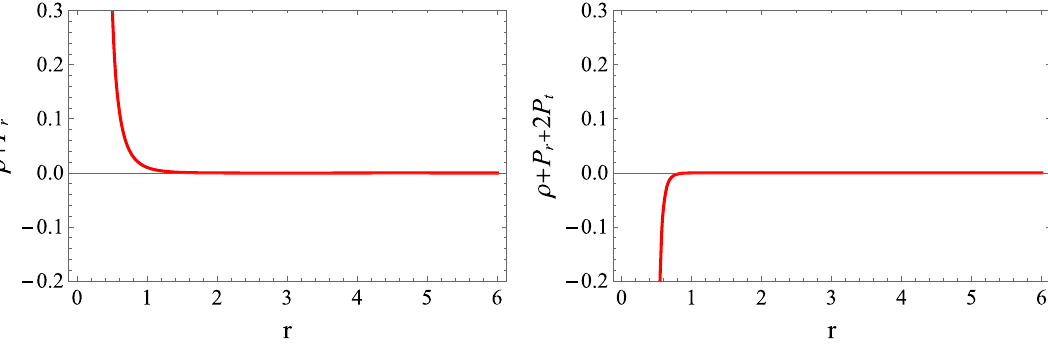
throughout the spacetime. We use the numerical values α = 0 . 1 and r 0 = 1, ρ 0 = 0 . 01 along with β = 4,